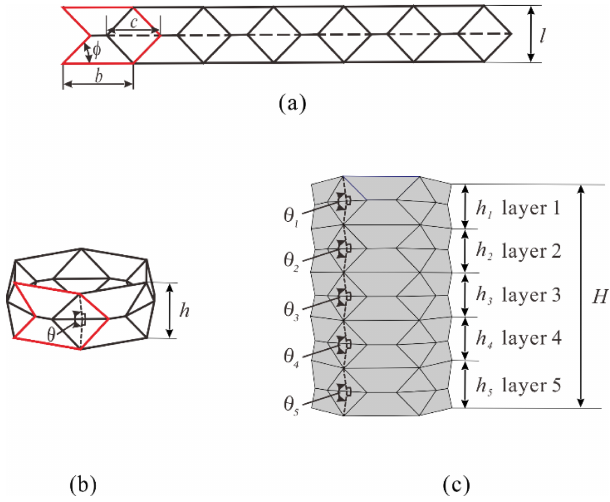
Figure 1. Geometry of the origami crash box: (a) the crease pattern; (b) a single-layer crash box; (c) a five-layer crash